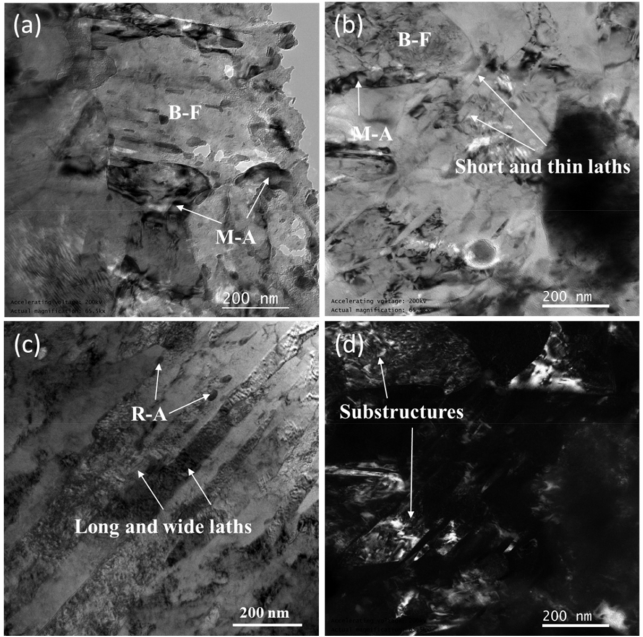
Figure 10. TEM morphology of SLM low-alloy steel samples grown with di ff erent EADs: ( a ) EAD = 142 J / mm 2 ; ( b ) EAD = 71 J / mm 2 ; ( c ) EAD = 47 J / mm 2 ; and ( d ) dark field image of ( b ). R-A: retained